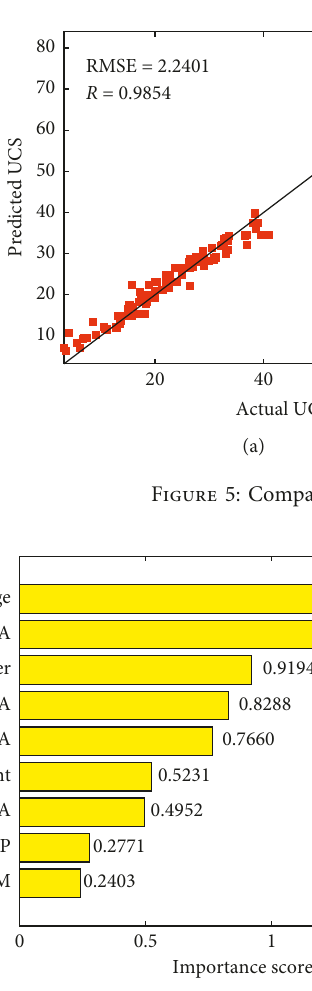
Figure 6: Variable importance of RC based on the